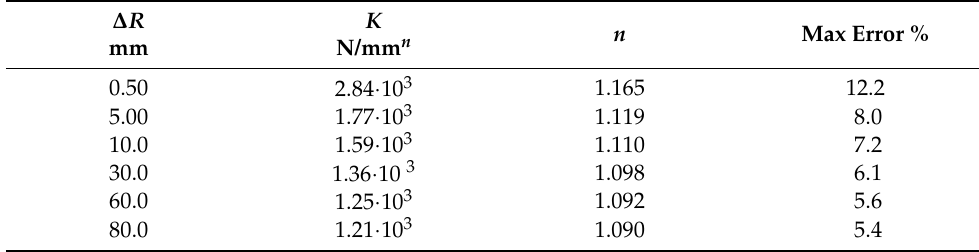
Table 8. Polynomial version of the EDSU-78035 [36] contact force model